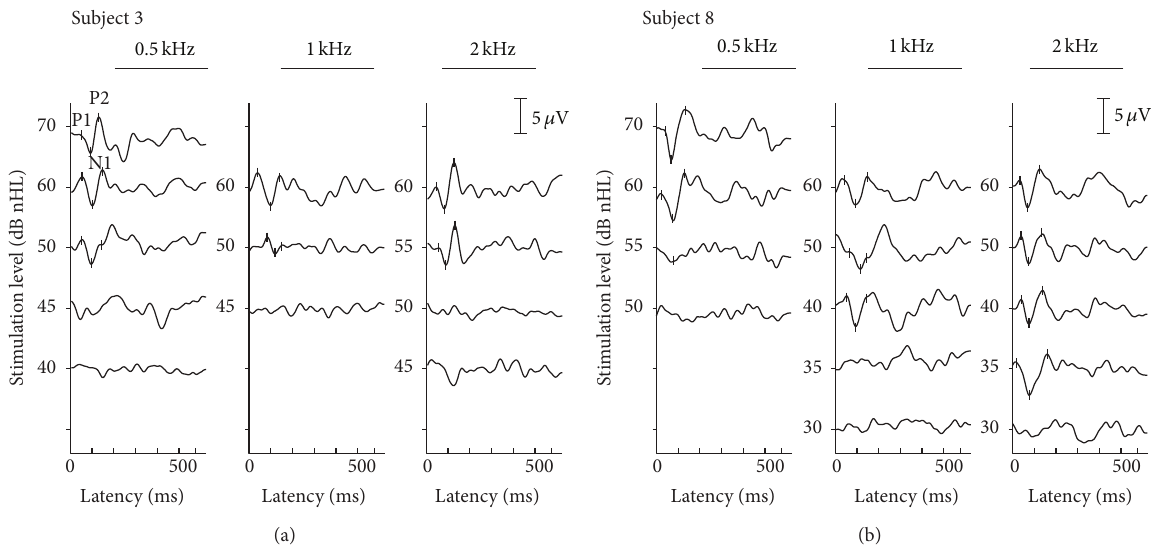
Figure 1: CAEP average waveforms recorded from the exemplary subjects 3 (a) and 8 (b) using a Baha Intenso with a softband as transducer. P1-N1-P2 waveforms are marked for the stimulation frequencies of 0.5 kHz, 1kHz, and 2kHz if present. The lowest stimulation level where the P1-N1-P2 waveform was discernible was defined as electrophysiological